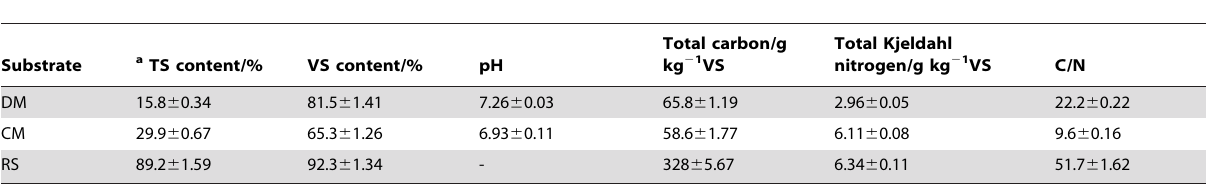
Table 1. Chemical characteristics of raw materials used in this